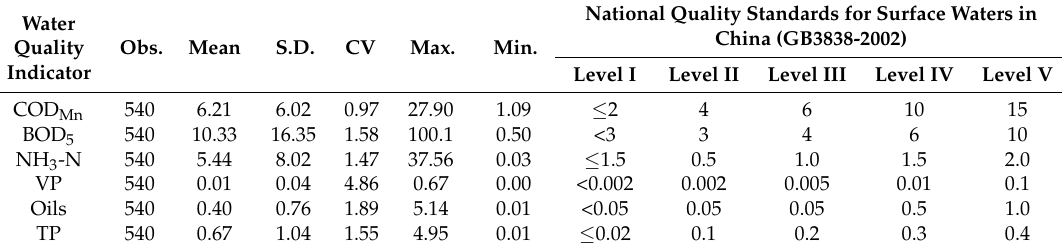
Table 1. Water quality characteristics in Shenzhen from 1990 to